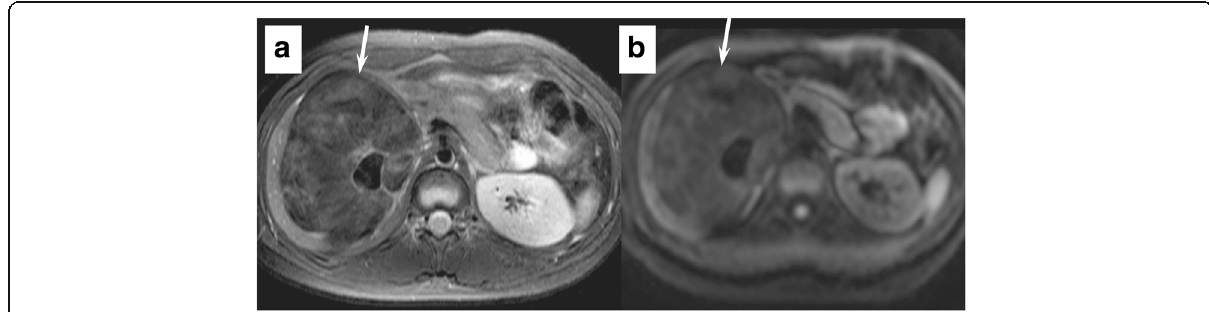
Fig. 2 Abdominal magnetic resonance imaging. a Fat-suppressed T2-weighted fast spin-echo image (TR/TE, 1600/80 ms) shows a heterogeneously hypointense lesion, suggestive of abundant fibrosis (arrow). b Diffusion-weighted echo-planar image (TR/TE, 2291/47 ms) shows heterogeneous hypointensity without strong diffusion restriction (ADC value=1.39×10 − 3 mm 2 /s) (arrow)